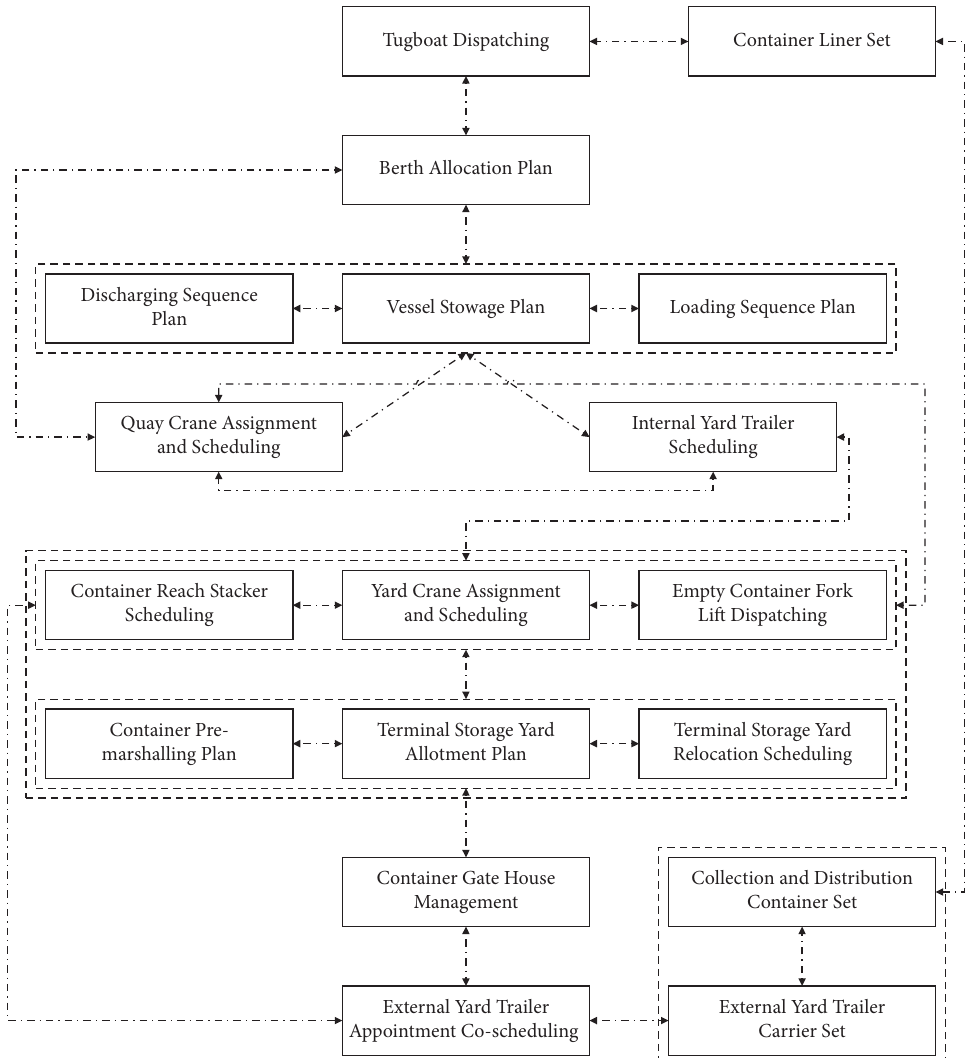
Figure 1: Container terminal logistics tactical operational complexity and intrinsic coupling